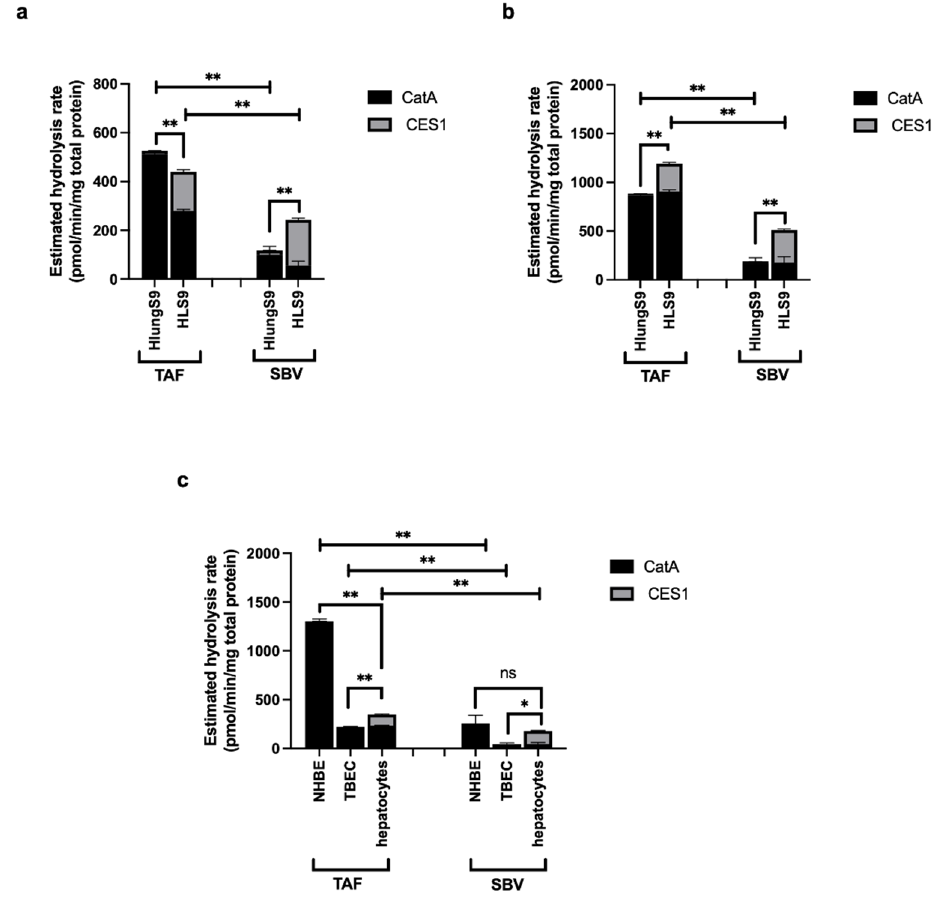
Figure 7. Estimated hydrolysis rates of TAF and SBV in human tissue S9 and primary cells. Estimated hydrolysis rates of TAF and SBV in human tissue S9 based on the enzyme abundance from the study by Li J. et al. [16] ( a ) and the study by Li R. et al. [13] ( b ) and in primary human cells ( c ). The estimated hydrolysis rate of a prodrug in a specific biological system was calculated by summing the CatA and CES1 mediated hydrolysis, which was calculated by timing the enzyme’s activity measured in this study (n = 3) with enzyme’s mean abundance extracted from previous studies (mean ± S.D.). NHBE: normal human bronchial epithelial cells; TBEC: tracheal bronchial epithelial cells. * p < 0.05 and ** p < 0.01 indicate statistically significant difference, “ns” indicates no significant difference. The difference between TAF and SBV hydrolysis rates in each specific biological system was analyzed by Student’s t -test; For each prodrug, the difference between HlungS9 and HLS9 was analyzed by Student’s t -test, and the differences among three primary cells were analyzed by ANOVA test.